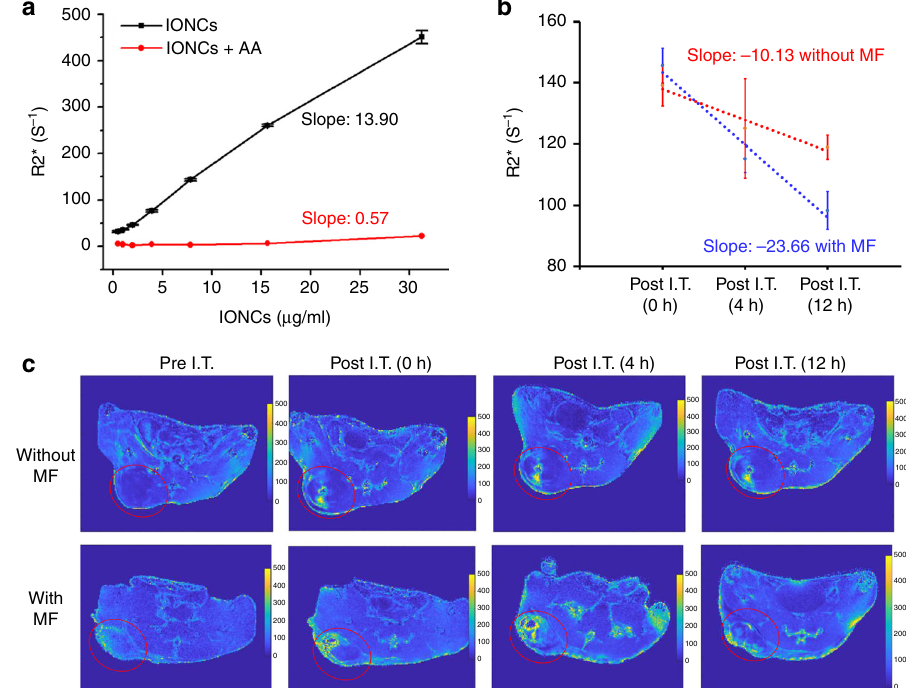
Fig. 2 Responsive MRI. a In vitro R2* value of IONCs treated with/without AA, R square are 0.9963 and 0.8287 for IONCs (black cure) and IONCs + AA (red curve), respectively. b In vivo R2* change after intra-tumoral injection of HCSVs treated with/without MF. R square are 0.9520 and 0.9741 for red curve (with MF) and blue curve (without MF), respectively. ( n = 3 independent samples) Data are shown as means± s.d. c Related R2* mapping after intra-tumoral injection of HCSVs treated with/without MF (red cycle indicated tumor region). Source data are provided as a Source data fi